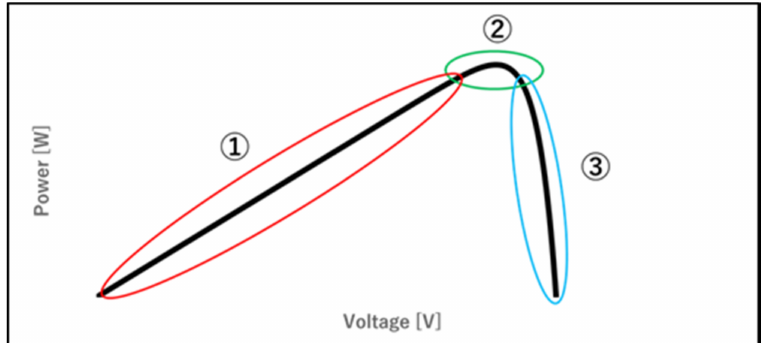
Figure 10. Power –voltage curve of the PV panel.